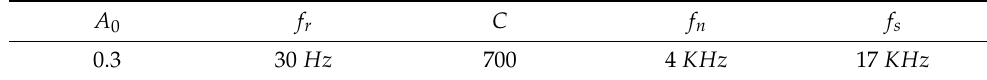
Table 1. The simulated signal parameter values.